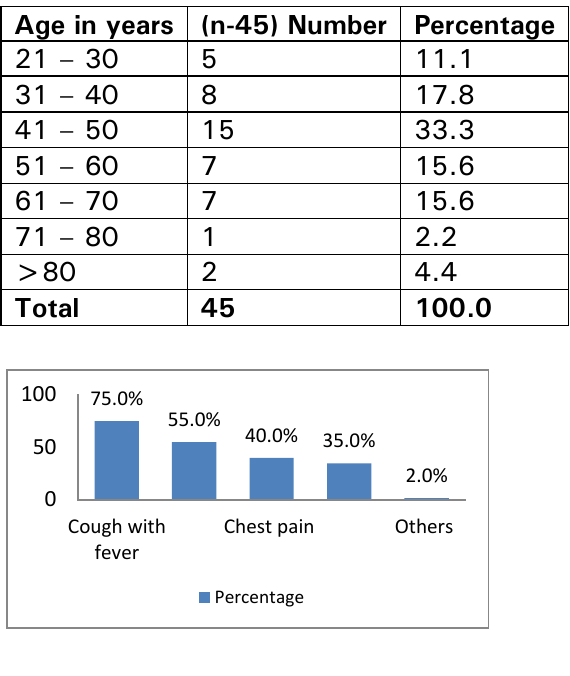
Figure 1. Common symptoms during presentation to hospital The most common symptom was cough with (75.0%) followed